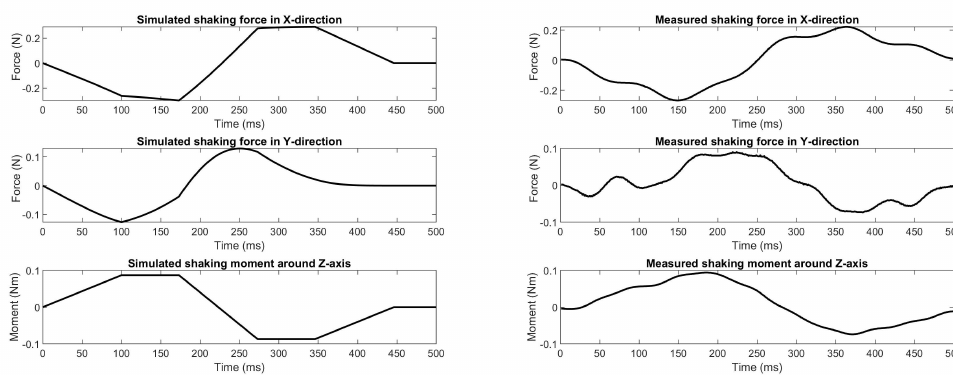
Figure 15. Comparison of the simulated and the measured shaking forces and shaking moment of the balanced manipulator arm with 50% of the tip mass with a maximal tip acceleration of 0.52 G. It is observed in Figure 15 that the measurements are close to the simulated values.